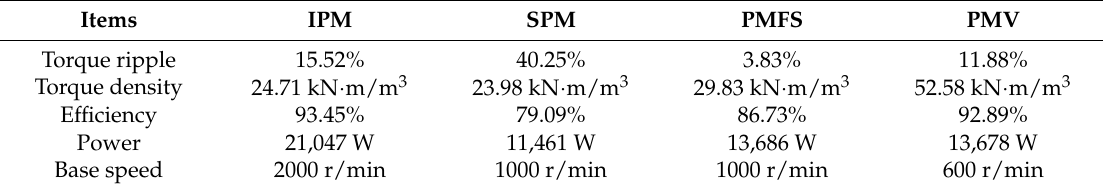
Table 4. Working Performance of Proposed Six-phase Outer-rotor Machines.